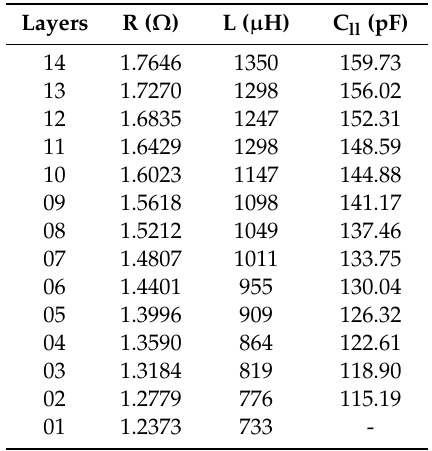
Table 9. Modified RLC parameters of HV winding for each of the layers with shield placement between HV and LV windings.